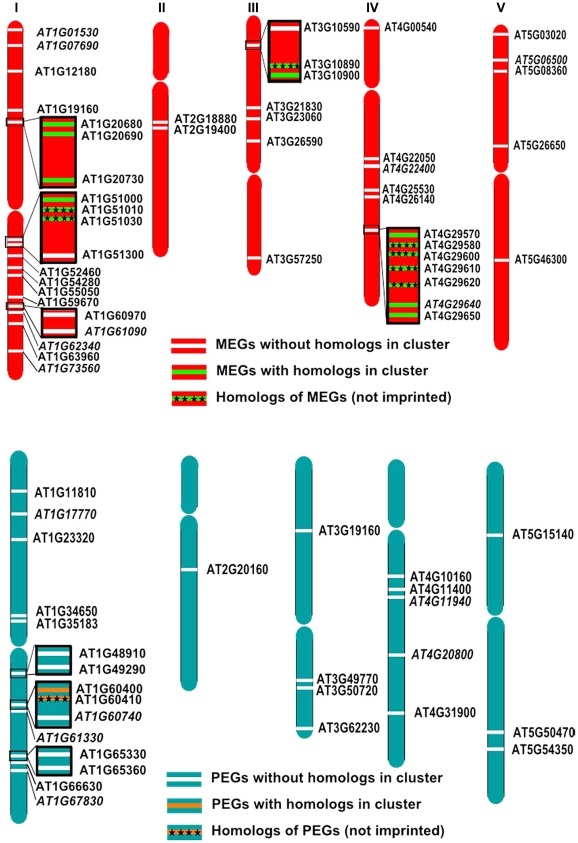
Some MEGs and PEGs Are Located in Clusters.Chromosomal distribution of MEGs and accession-dependent MEGs (A) and PEGs and accession-dependent PEGs (B) along the chromosomes. Accession-dependent MEGs and PEGs are italicized. Genes located in clusters are boxed. Clustered MEGs and PEGs having homologs within the cluster are highlighted in green and orange, respectively. Non-imprinted homologs of clustered MEGs and PEGs are indicated by cross signs.